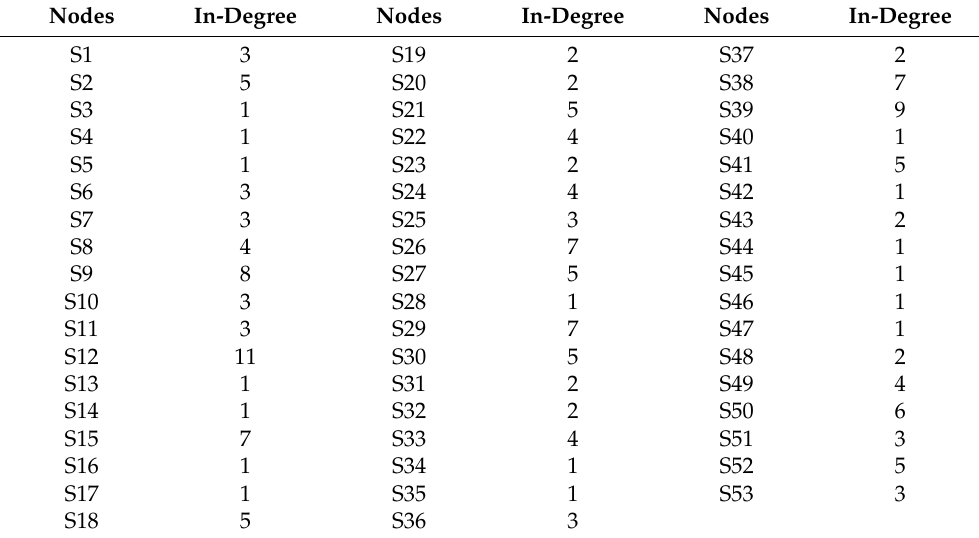
Table 2. Dataset: Result in-degree